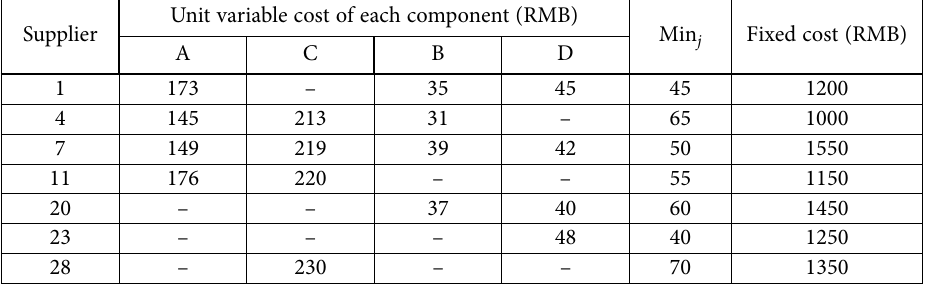
Table 32. Fixed and variable costs of components A–D